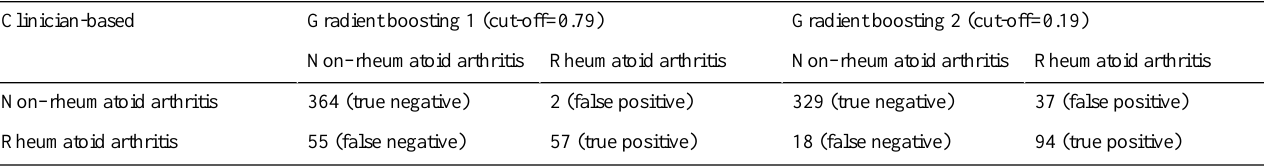
Table 2. Gradient boosting confusion matrices for the Erlangen-B test set